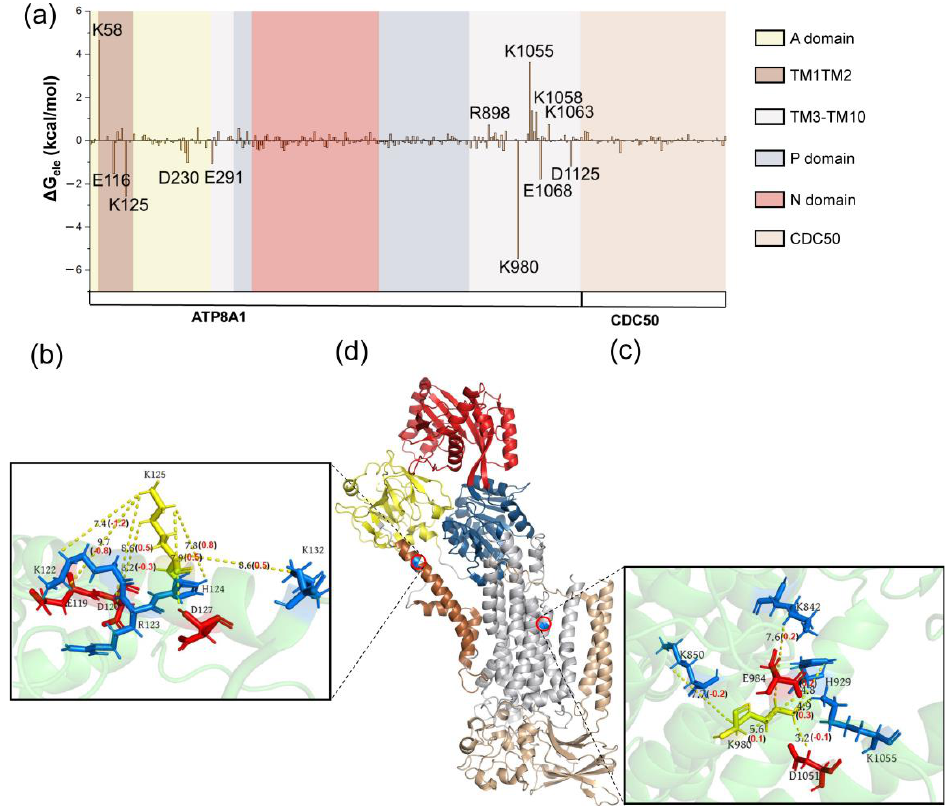
Figure 6. ( a ) The electrostatic contribution of residues for structures I2 and T2. The interaction map of K125 ( b ), K980 ( c ) and their corresponding position in the P4-ATPase ( d ). The positively charged residues are colored blue, and the negatively charged residues are shown in red.